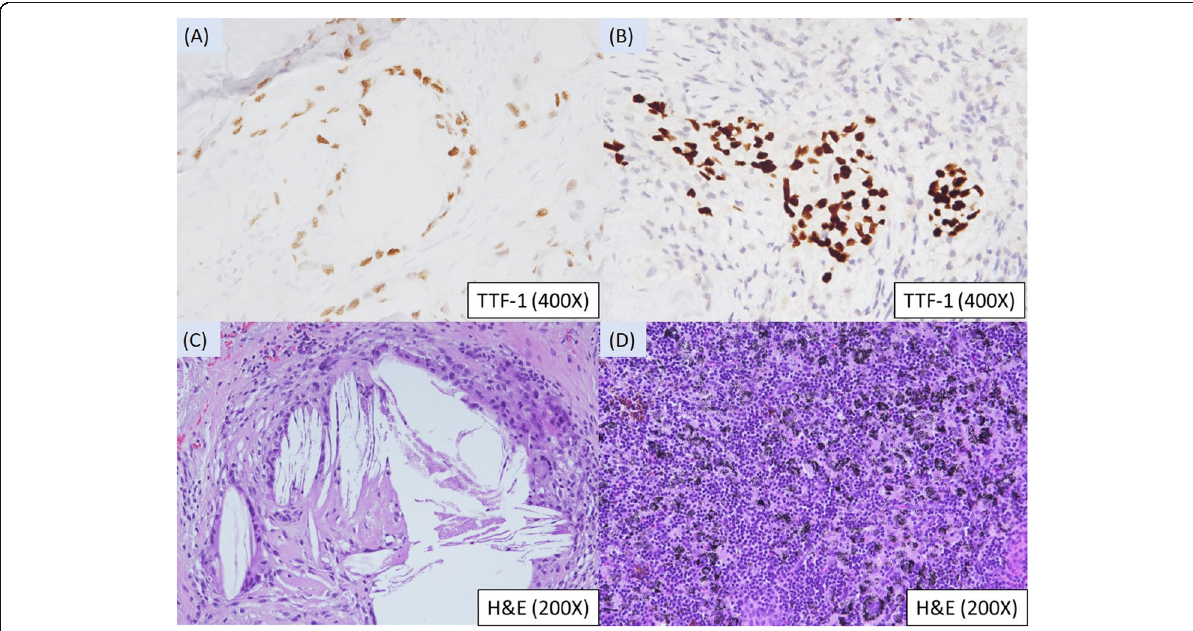
Fig. 2 Biopsies and staining results. a Biopsy from the third lumbar vertebra, TTF-1(+). b Bronchoscopic biopsy from the RB10, TTF-1(+). c Lung adenocarcinoma with complete tumor regression with cholesterol crystals and multinucleate giant cells. Hematoxylin and eosin stains. d Lymph node: anthracosis